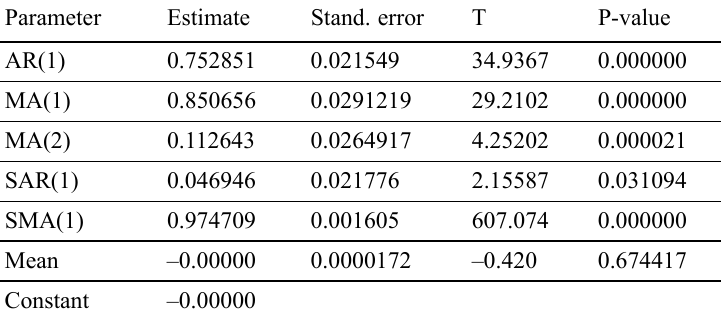
Table 3. Parameters estimates of SARIMA model (1,1,2)(1,1,1)